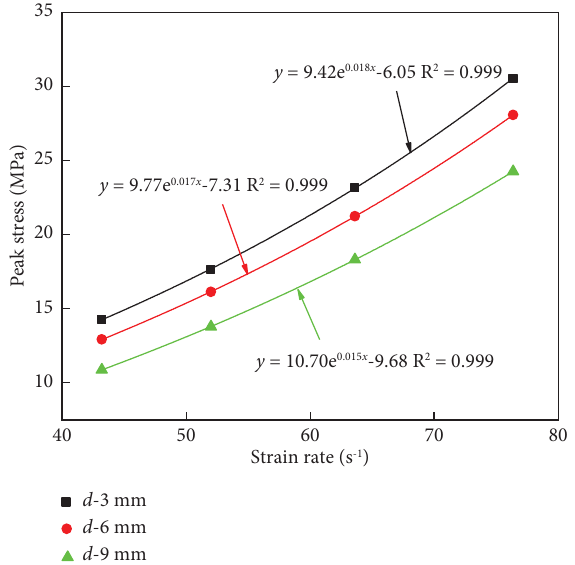
Figure 8: Relationship between the peak stress and strain rate of the composite specimen when the water content is 36%.